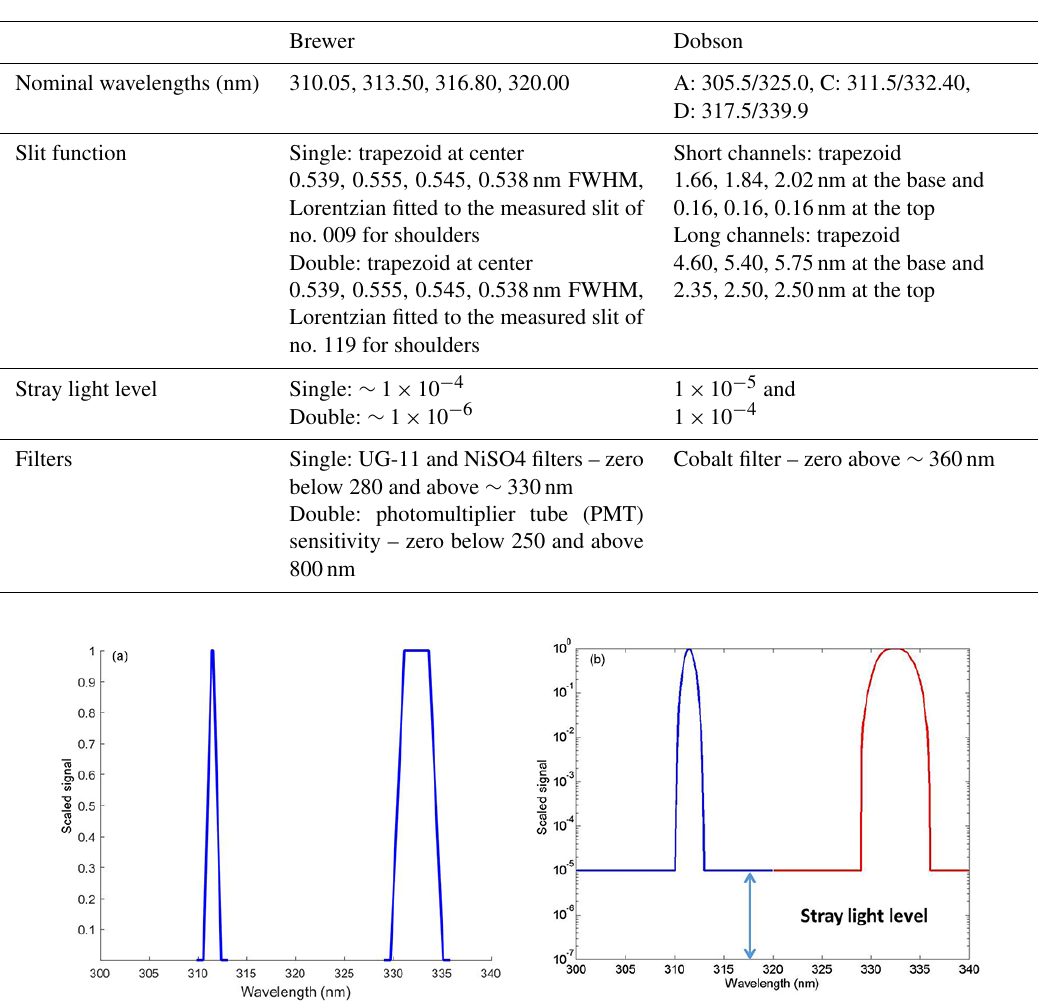
Table 1. Brewer and Dobson optical parameters.